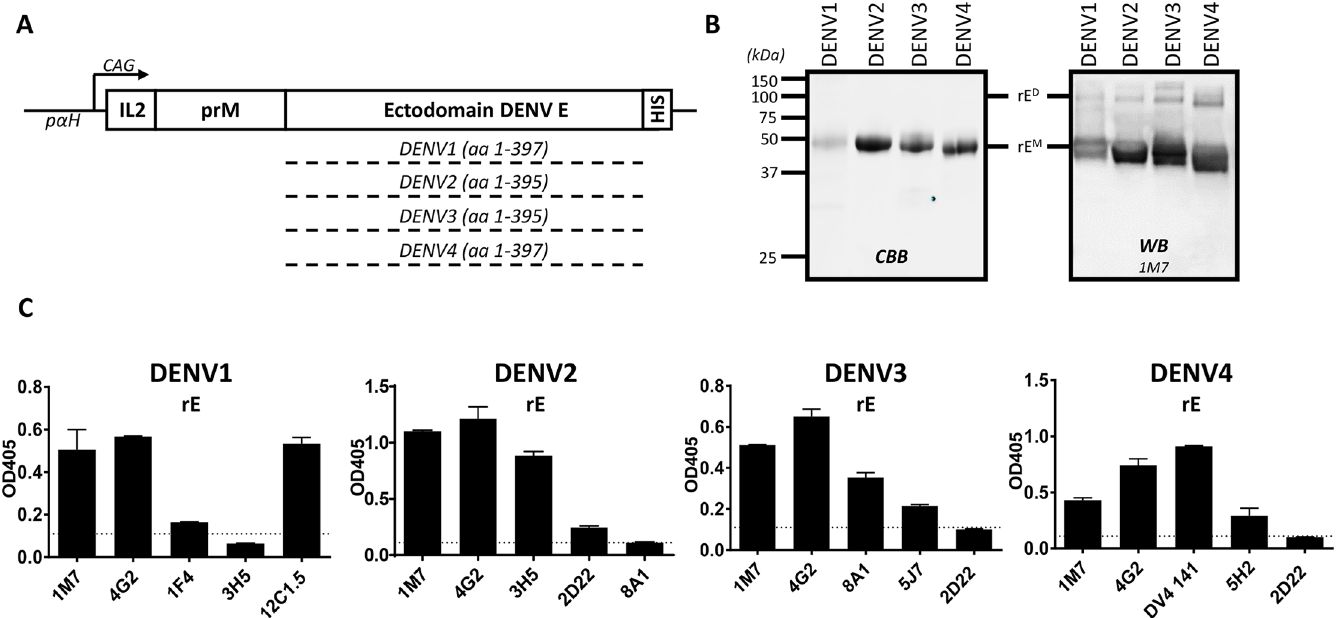
Fig 1. Expression and characterization of DENV1-4 rE. A) Schematic representation of the DENV1-4 rE expression constructs. The ectodomain of DENV1-4 E was expressed together with the homotypic prM protein, upstream an IL2 leader peptide. Recombinant proteins were equipped with a C-terminal His-tag and expressed under control of a CAG promoter on a p α H-expression vector in EXPI293 cells. B) Purified rE was subjected to SDS-PAGE and analyzed with CBB and WB using a 1M7 human derived mAb. C) DENV1-4 rE purified proteins fractions were loaded on Ni 2+ -coated ELISA plates and analyzed with a panel of cross-reactive or serotype specific mAbs (DENV1-1F4; DENV2-3H5, 2D22; DENV3-8A1, 5J7; DENV4-DV4 141, 5H2).